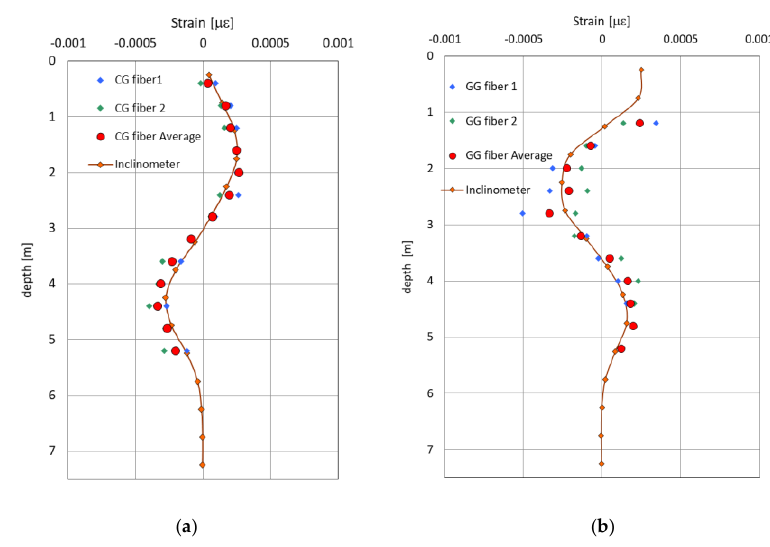
Figure 13. Experiment 3 strain diagram: ( a ) CG transducer, ( b ) GG transducer.